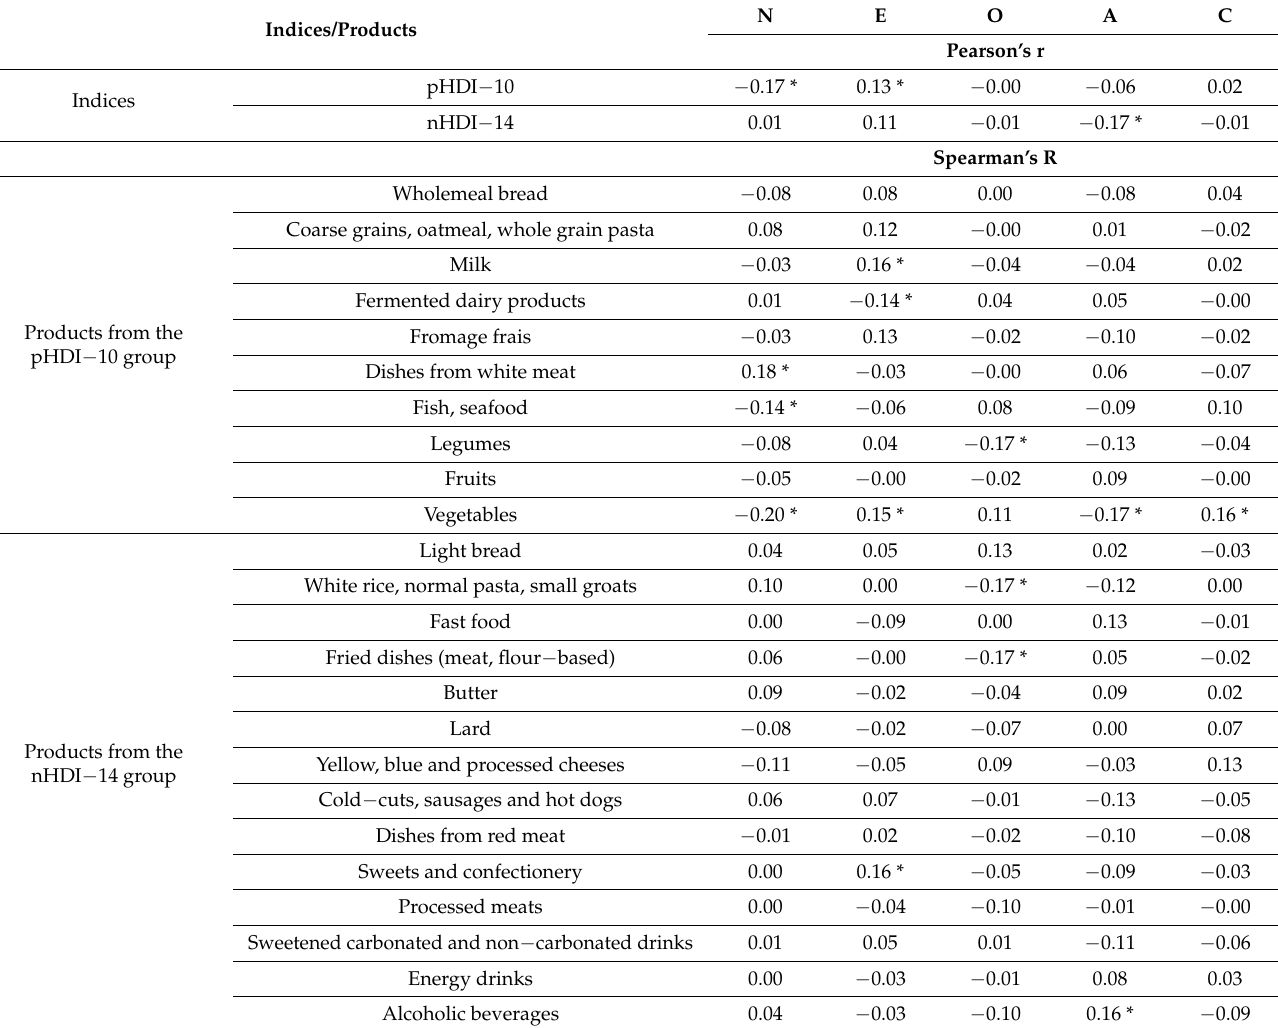
Table 5. Correlations between the personality traits of the five-factor model and the indices of pro- healthy (pHDI-10) and non-healthy (nHDI-14) diets, personality traits as well as the daily frequency of consuming products with potentially beneficial and potentially adverse effects on health (N = 213) (Pearson’s r and Spearman’s R signed rank correlation